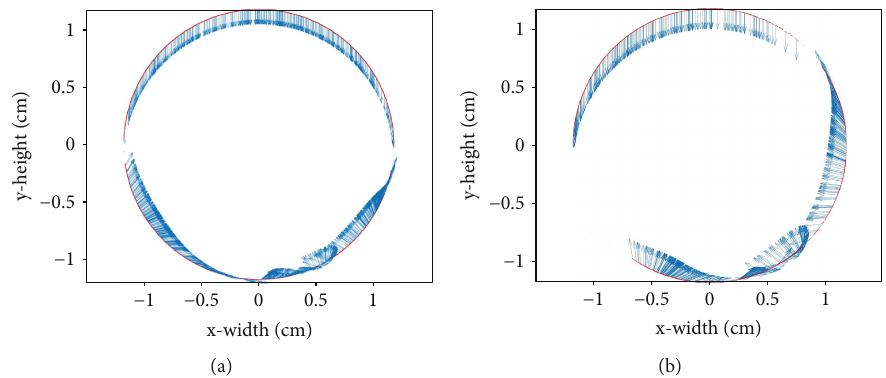
Figure 3: Photon vectors impinging on the receiver tube at 13:00h, for (a) March 21 and (b) December